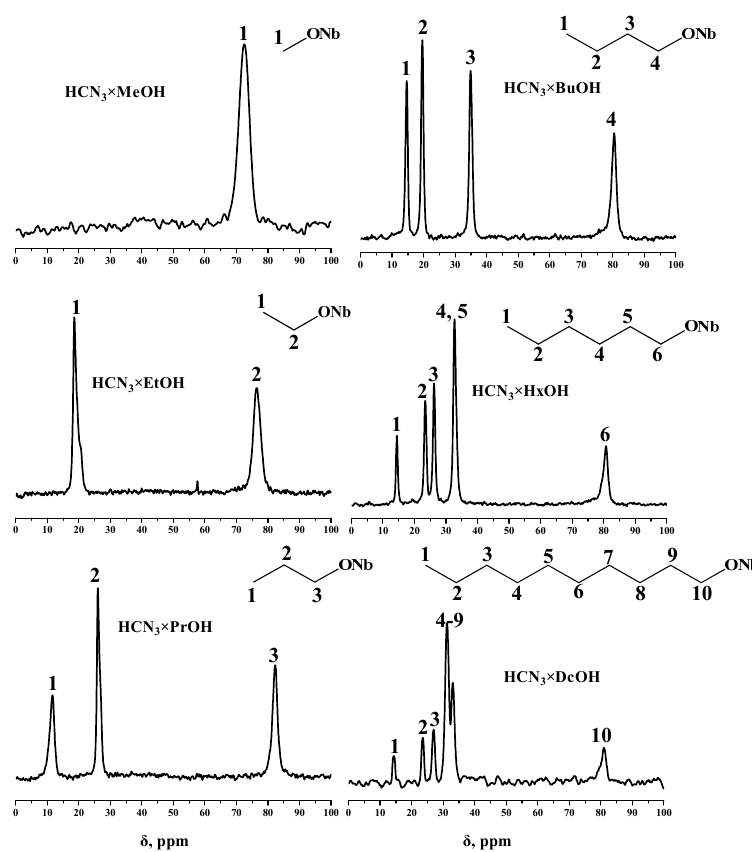
Figure 4. 13 C NMR spectra of the n -alkoxy derivatives.